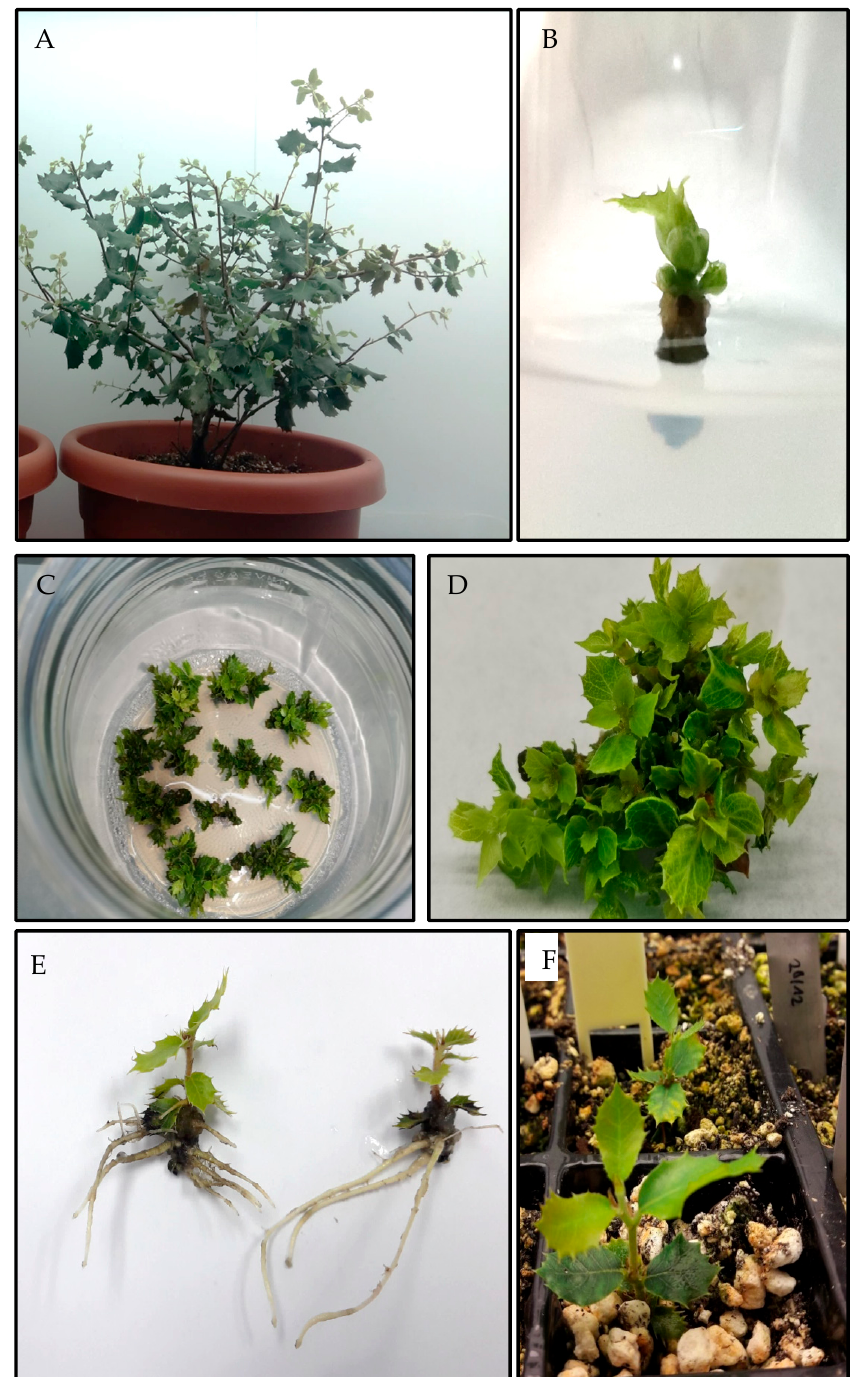
Figure 1. Micropropagation of tolerant holm oak plants by axillary shoot proliferation. ( A ) Forced flushing of the potted plant placed in a growth chamber. ( B ) Axillary shoot arising from a nodal explant after eight weeks of culture. ( C , D ) Shoot cultures appearance of genotype E2-1 after growth in proliferation medium. ( E ) Root development on PR11 shoots treated with 25 mg L − 1 IBA for 48 h and subsequent transfer to auxin free medium containing 20 µ M STS (sterilized silver thiosulphate). ( F ) Acclimatized plants of genotype PR11 after six weeks in the growth